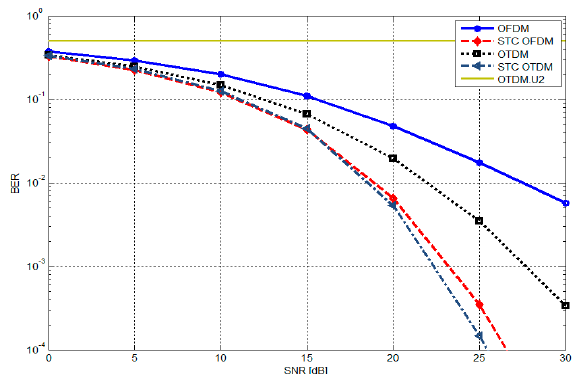
Figure 4. BER of the proposed technique (STC OTDM) in comparison with other multicarrier techniques at N = 16 and L = 9 using 64-QAM.